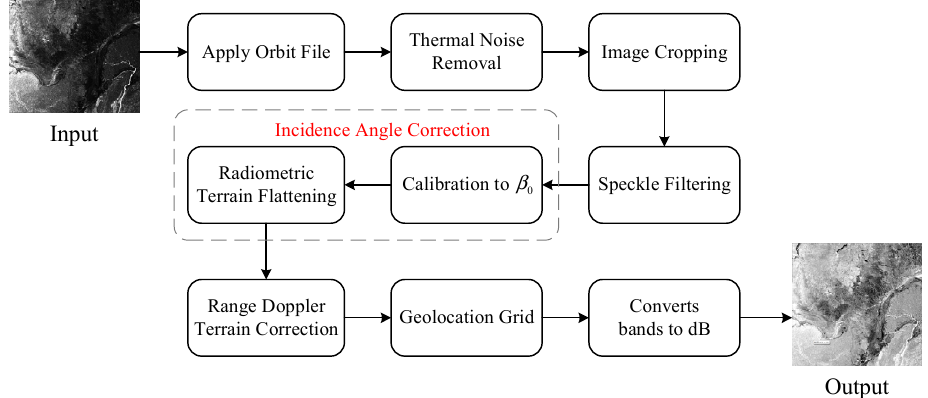
Figure 2. The detailed preprocessing procedures of Sentinel-1 EW data.